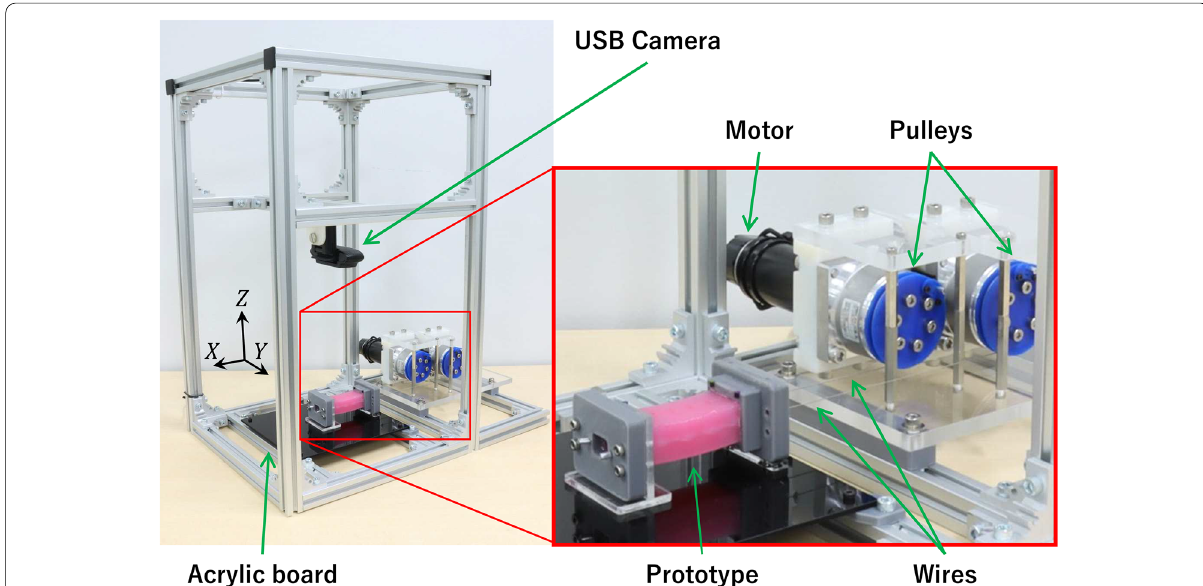
Fig. 6 Experimental equipment. The base is fixed to a black acrylic plate which is fixed to the frame. The cap can be moved planarly on the black acrylic plate